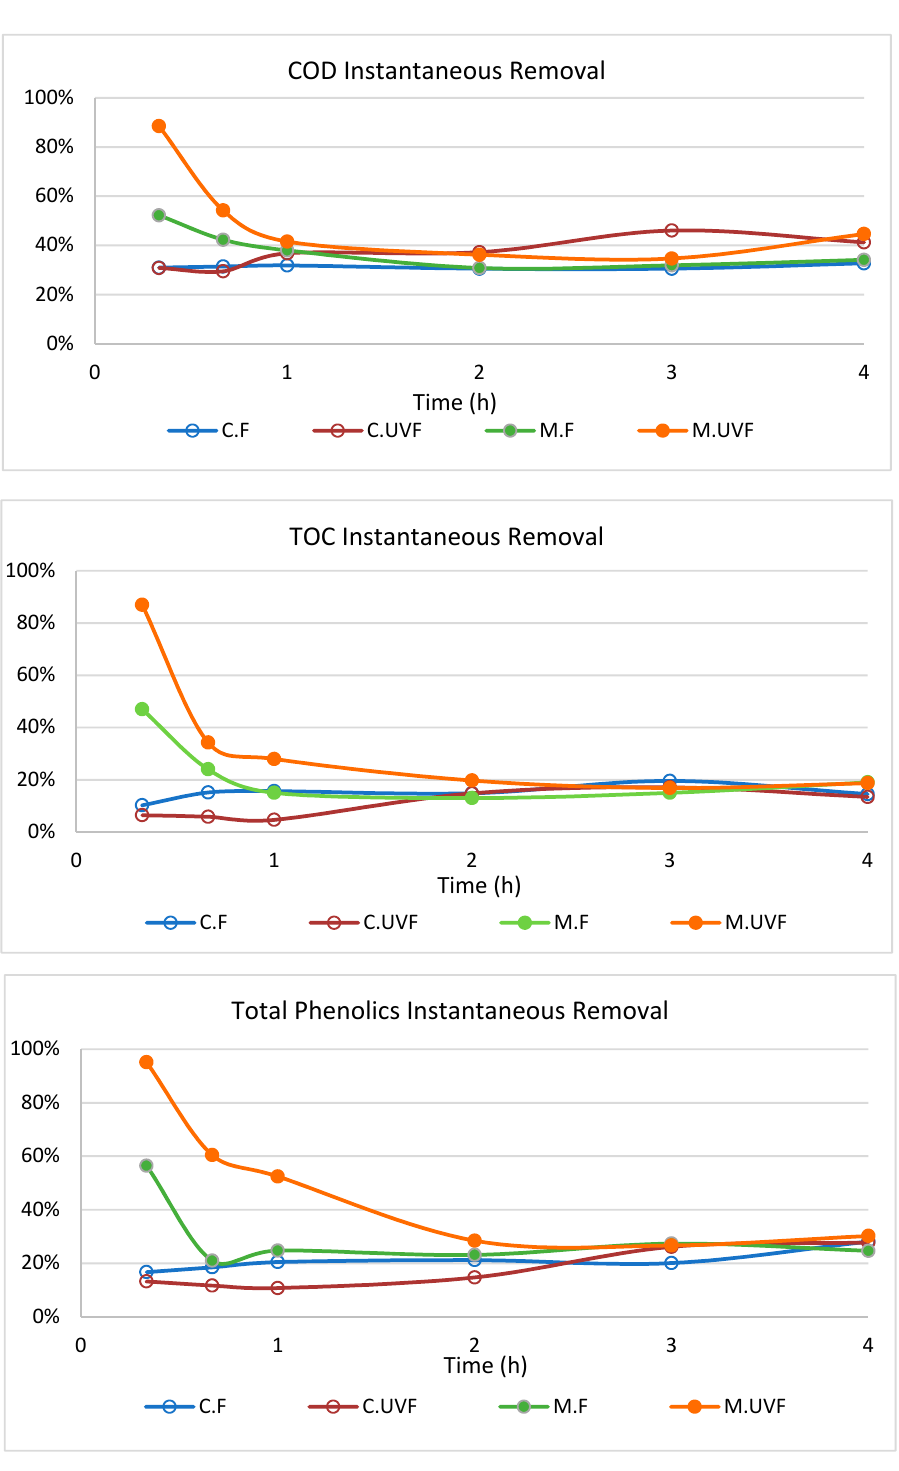
Figure 4. Percent removals of chemical oxygen demand (COD), total organic carbon (TOC) and phenolic compounds in the different tests: C.F, C.UVF, M.F and M.UVF.